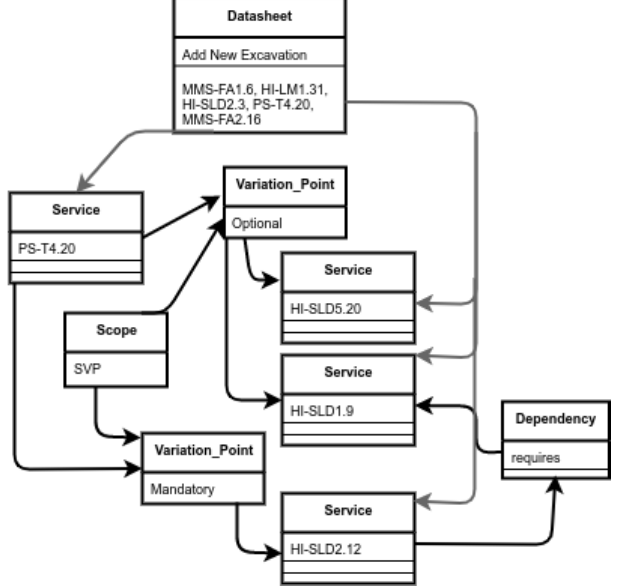
Figure 8. Part of the instantiation of Add New Excavations functionality of Figure 7.